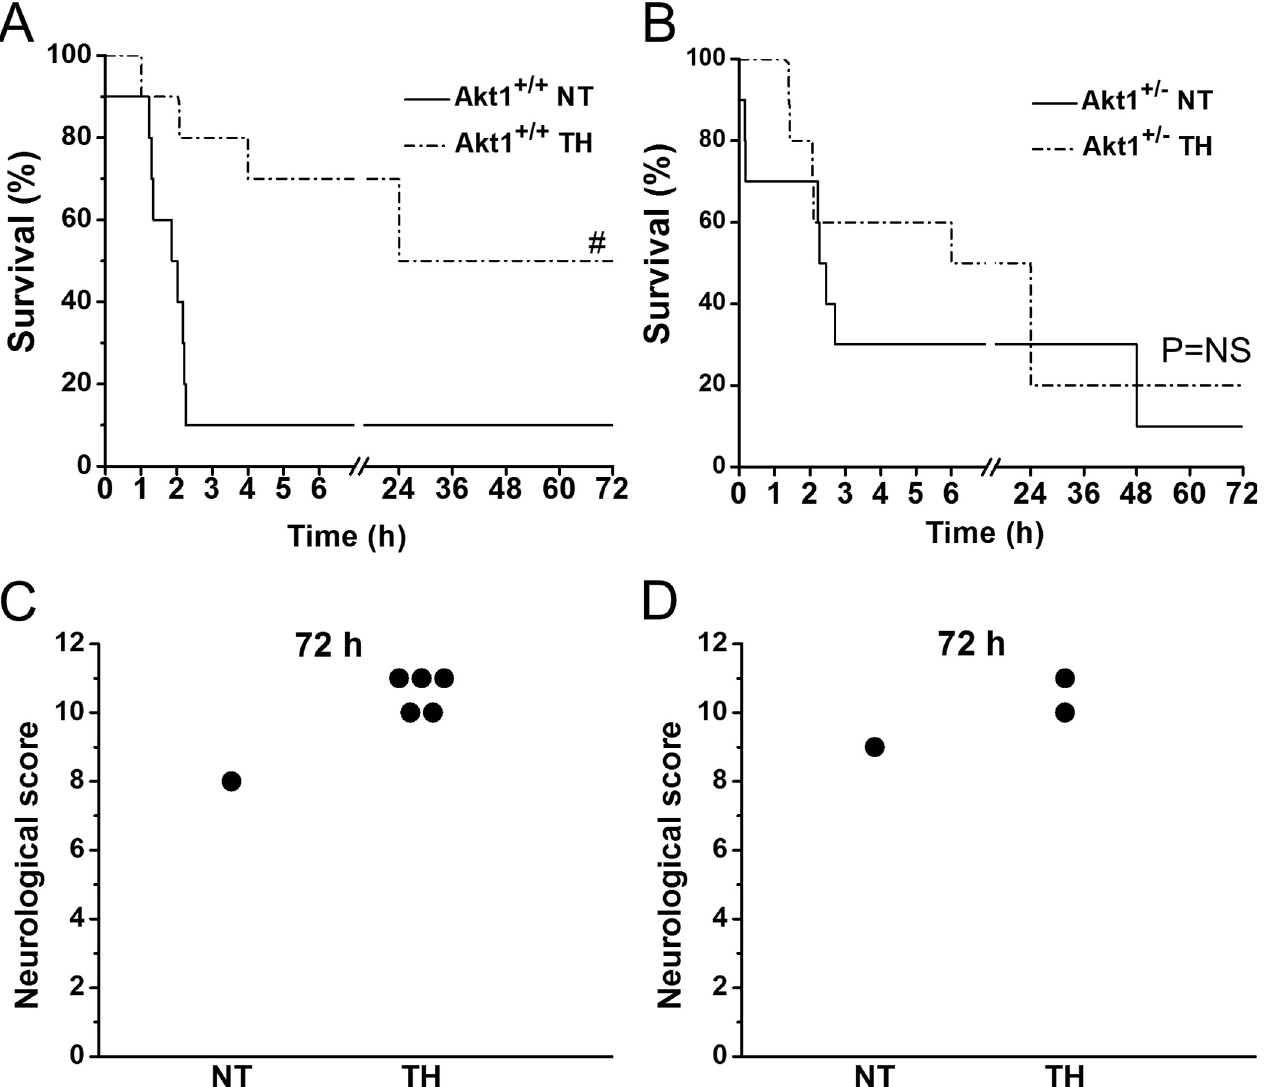
Fig 1. Effect of Akt1 on TH-induced neurological function and survival after SCA. A : Kaplan-Meier 72 h survival plot of NT and TH groups (n = 10 in each group, # p < 0.05 between NT and TH groups) in Akt1 +/+ mice. B : Kaplan-Meier 72 h survival plot of NT and TH groups (n = 10 in each group, p = NS) in Akt1 +/- mice. C : Assessment of Neurological function score (0 representing death of the animal and 12 reflecting a full neurological recovery) at R72h in Akt1 +/+ mice. D : Assessment of neurological function score at R72h in Akt1 +/-